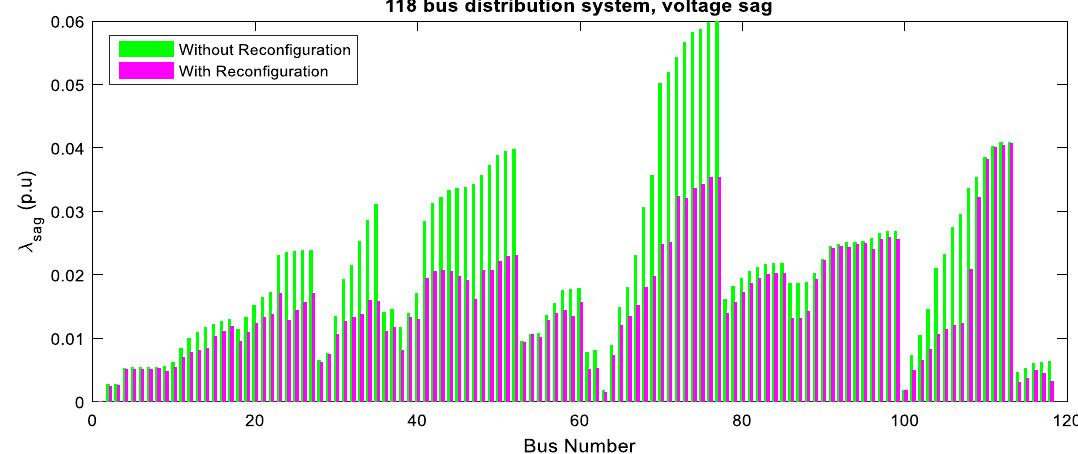
Figure 11. Voltage sag of 118-bus network via ITSOA with and without optimal configuration.